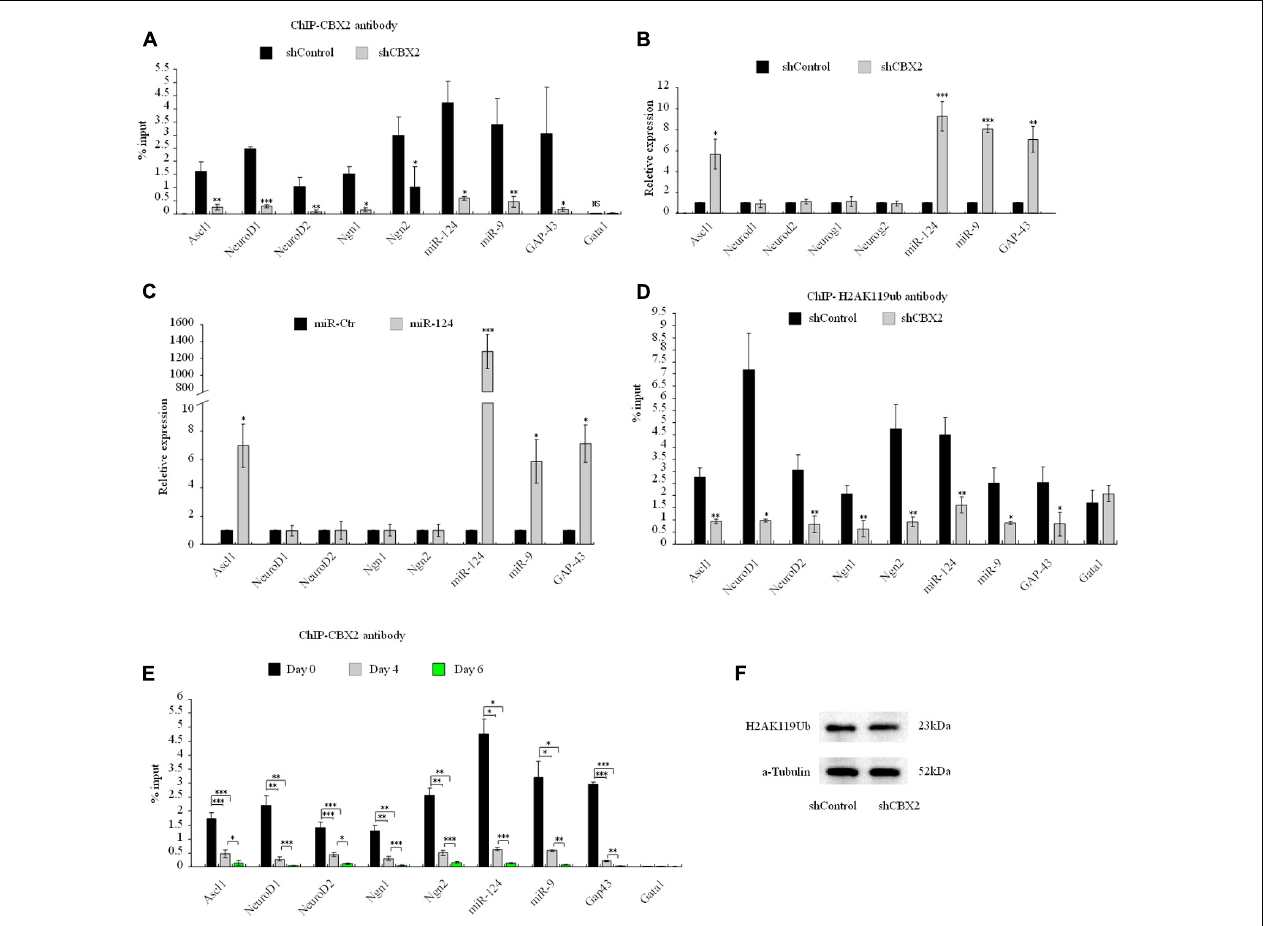
FIGURE 5 | CBX2 directly binds to the promoter of several neuronal genes and regulates the expression of some of them. (A) ChIP-qPCR analysis of the enrichment of CBX2 at selected gene promoters in control and CBX2 knocked-down M17 cells. The data are presented as mean ± SD, n = 3, ∗∗∗ P < 0.001. (B) RT-qPCR analysis of selected genes in control and CBX2 knocked-down M17 cells. The data are presented as mean ± SD, n = 30, ∗ P < 0.05, ∗∗ P < 0.01, ∗∗∗ P < 0.001. (C) RT-qPCR analysis of selected genes in control and miR-124 over-expressed M17 cells. The data are presented as mean ± SD, n = 3, ∗ P < 0.05, ∗∗∗ P < 0.001. (D) ChIP-qPCR analysis of the enrichment of H2AK119Ub at selected gene promoters in control and CBX2 knocked-down M17 cells. The data are presented as mean ± SD, n = 3, ∗∗ P < 0.01, ∗∗∗ P < 0.001. (E) ChIP-qPCR analysis of the enrichment of CBX2 at selected gene promoters in during M17 cells neuronal differentiation. The data are presented as mean ± SD, n = 3, ∗ P < 0.05, ∗∗ P < 0.01, ∗∗∗ P < 0.001. (F) Immunoblotting analysis is shown of H2AK119Ub expression in control and CBX2 knocked-down M17